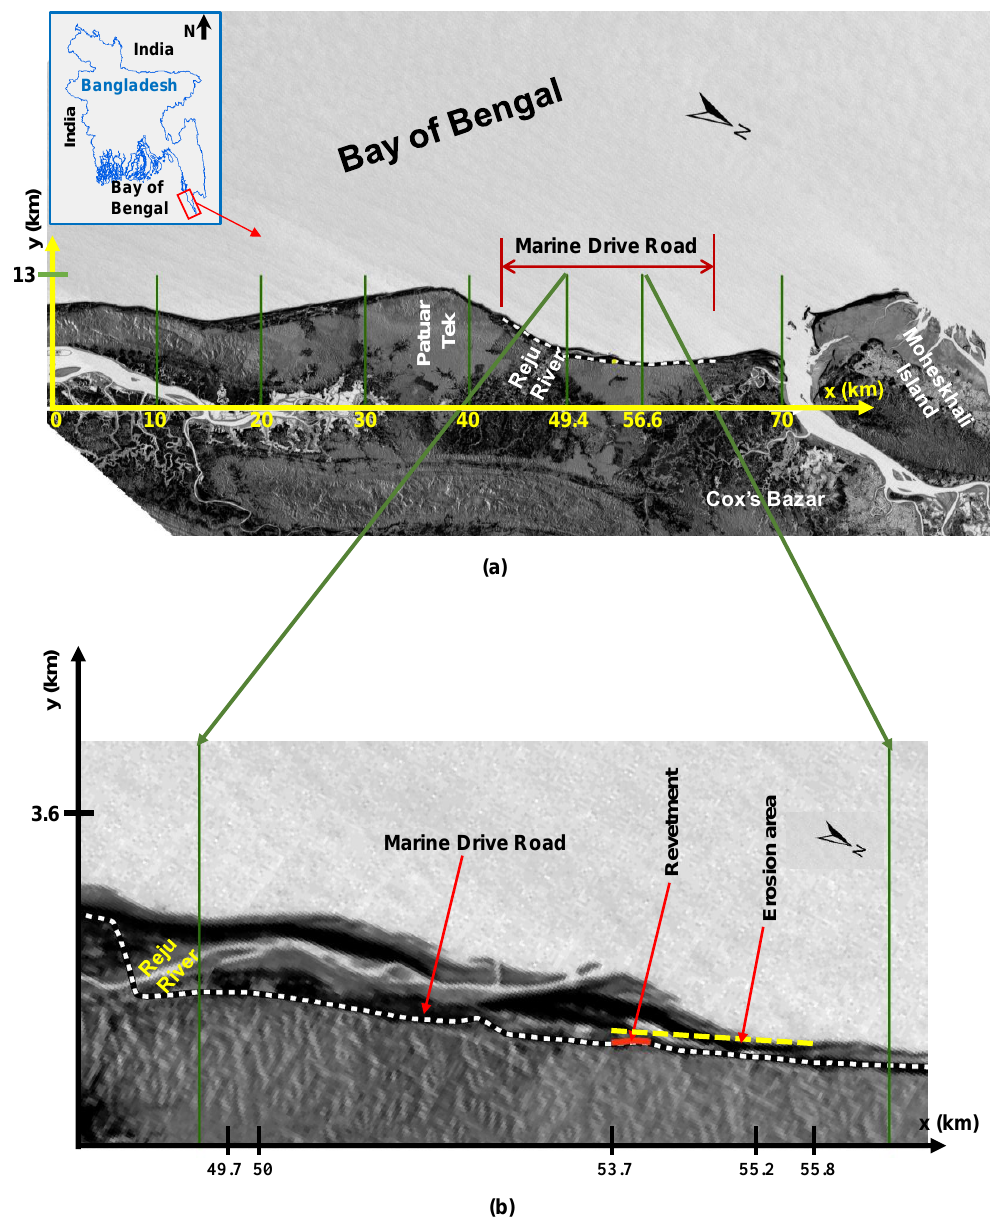
Figure 1. ( a ) Overall coastline of Cox’s Bazar, Bangladesh; and ( b ) the location of the study area. Image taken on 13 January